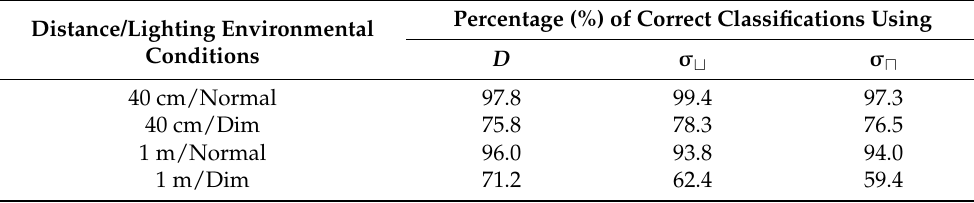
Table 4. Results by the optimized GbCvector classifier for four different environmental conditions.